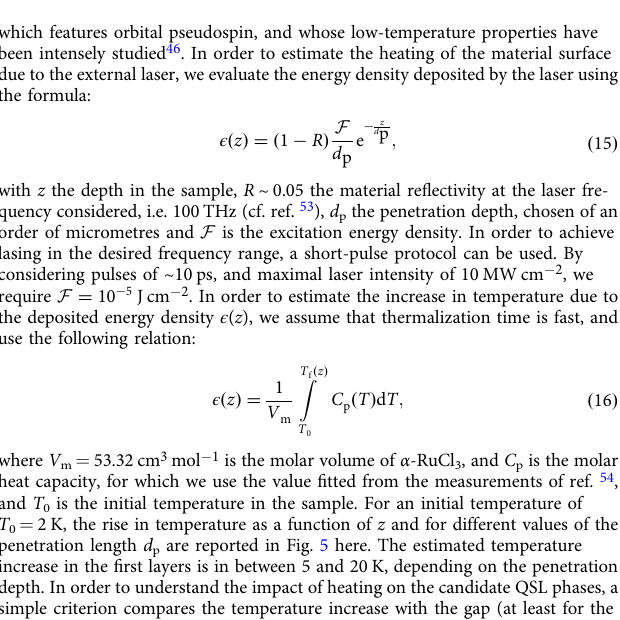
Fig. 5 Heating effects. Laser-induced temperature increase as a function of the depth in the sample, for different values of the laser penetration depths.